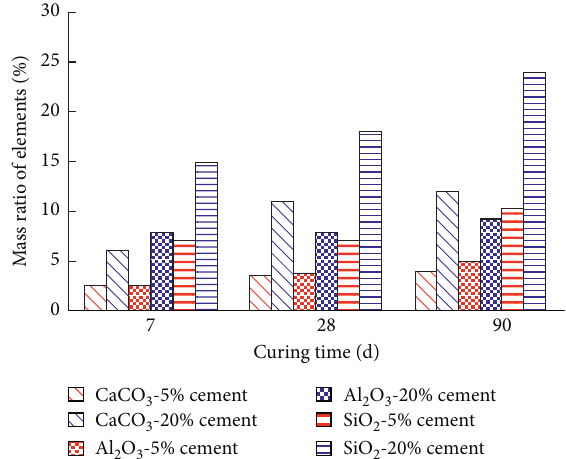
Figure 18: The relationship between mass ratios of various elements with different cement contents.